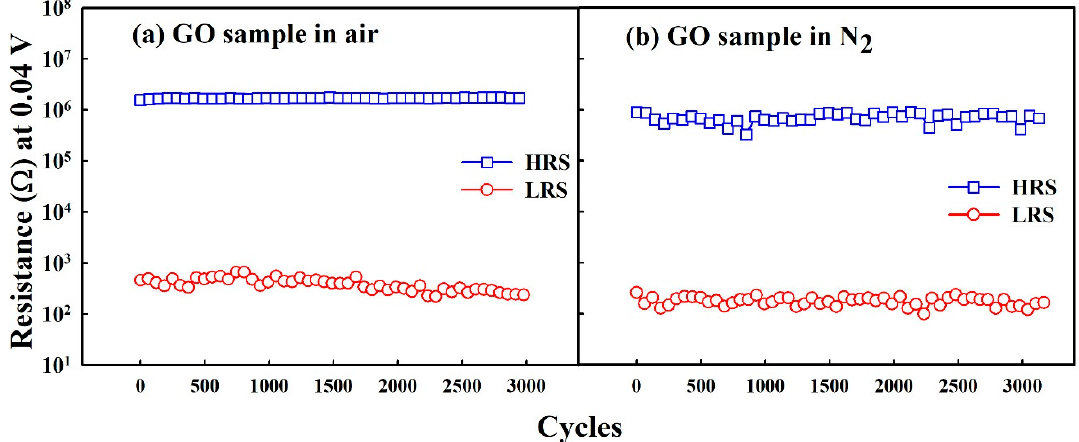
Figure 5. Endurance characteristics of the GO sample in ( a ) the atmosphere and ( b ) the N 2 ambient.